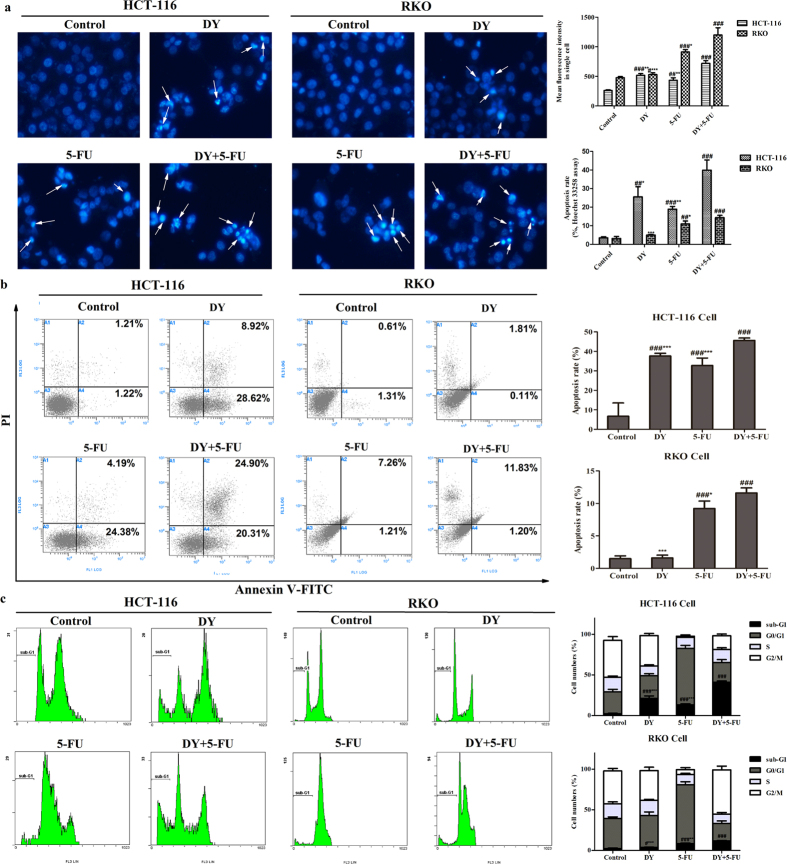
DY synergistically induced apoptosis in CRC cells when treated with 5-FU.(a) Cells treated with DY and/or 5-FU for 48 h were loaded with Hoechst 33258 probes, and cells with condensed or fragmentary nucleus (arrow) were observed under a fluorescence microscope (200×). The mean fluorescence intensity of Hoechst 33258 in single cell and apoptotic rates were quantified (see right histograms) as well. (b) Apoptotic CRC cells stained with Annexin V-FITC/PI were detected by flow cytometry system (FCMS), and apoptotic rates are showed in right bars. (c) Cells were stained by PI & RNase and DNA contents were then measured by FCMS. Cells arrested in the sub-G1 phase are considered to undergo late apoptosis. All data are expressed as mean ± SD (n = 3). #P < 0.05, ##P < 0.01, ###P < 0.001, vs control group. While *P < 0.05, **P < 0.01, ***P < 0.001, vs (DY + 5-FU) group.